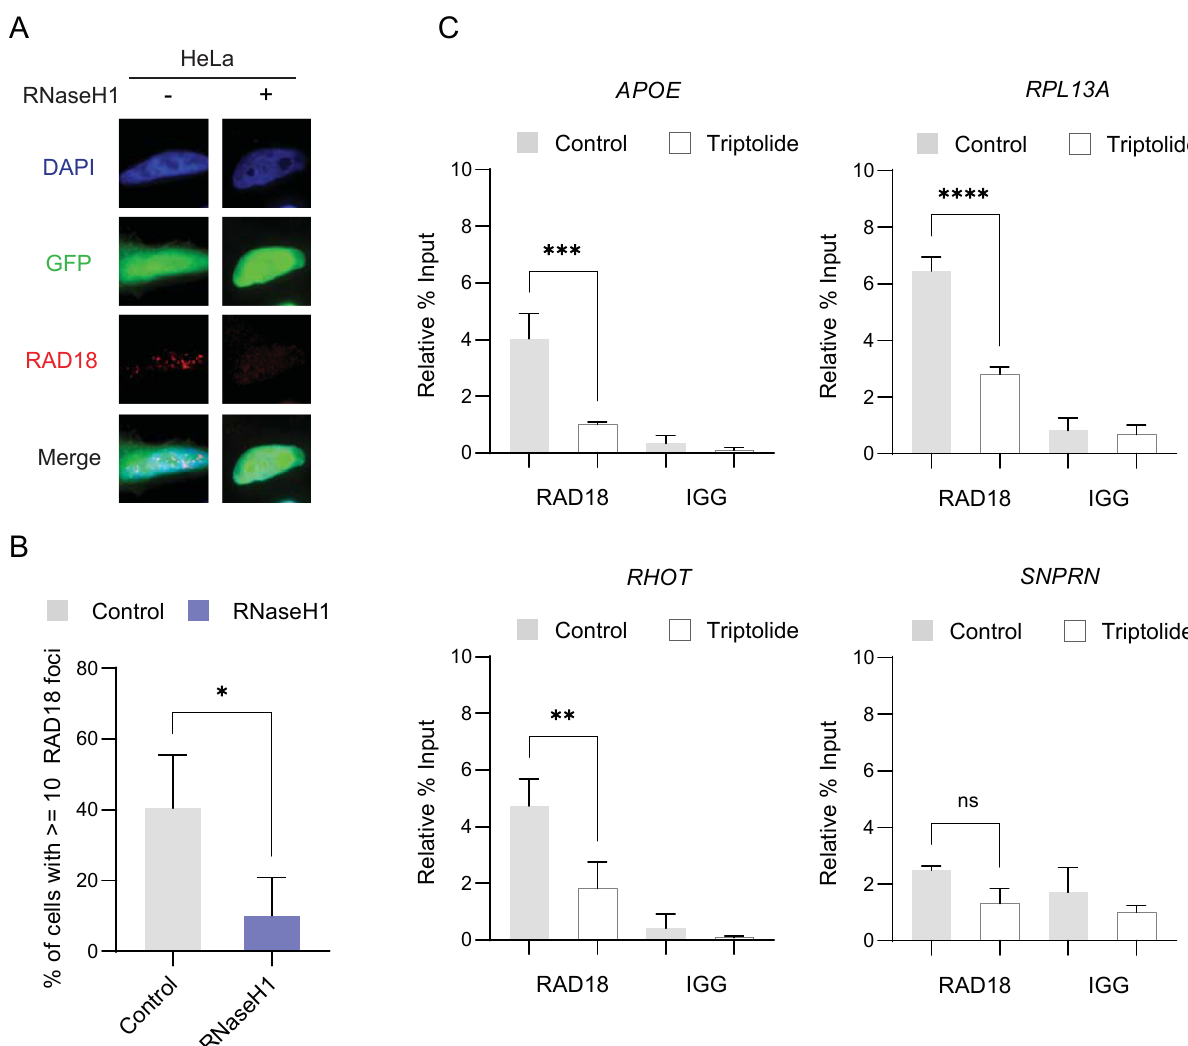
Fig 2. RAD18 localization is dependent on R-loop formation and transcriptional activity. (A-B) Suppression of spontaneous RAD18 foci in GFP- tagged RNaseH1 transfected cells. A, representative images, B, quantification. (C) RAD18 ChIP in Hela cells at R-loop prone sites APOE, RPL13A, RHOT2, and negative control site SNPRN with and without a 2 hour treatment of triptolide and compared to an IGG negative control. Treatment concentrations of triptolide (40 nM). (B) Student T Test (C) ANOVA. p < 0.05, N = 3 for all. Error bars represent standard deviation and the central line represents the mean. ns , not significant; � , p < 0.05; �� , p < 0.01; ��� , p < 0.001; ���� , p < 0.0001.